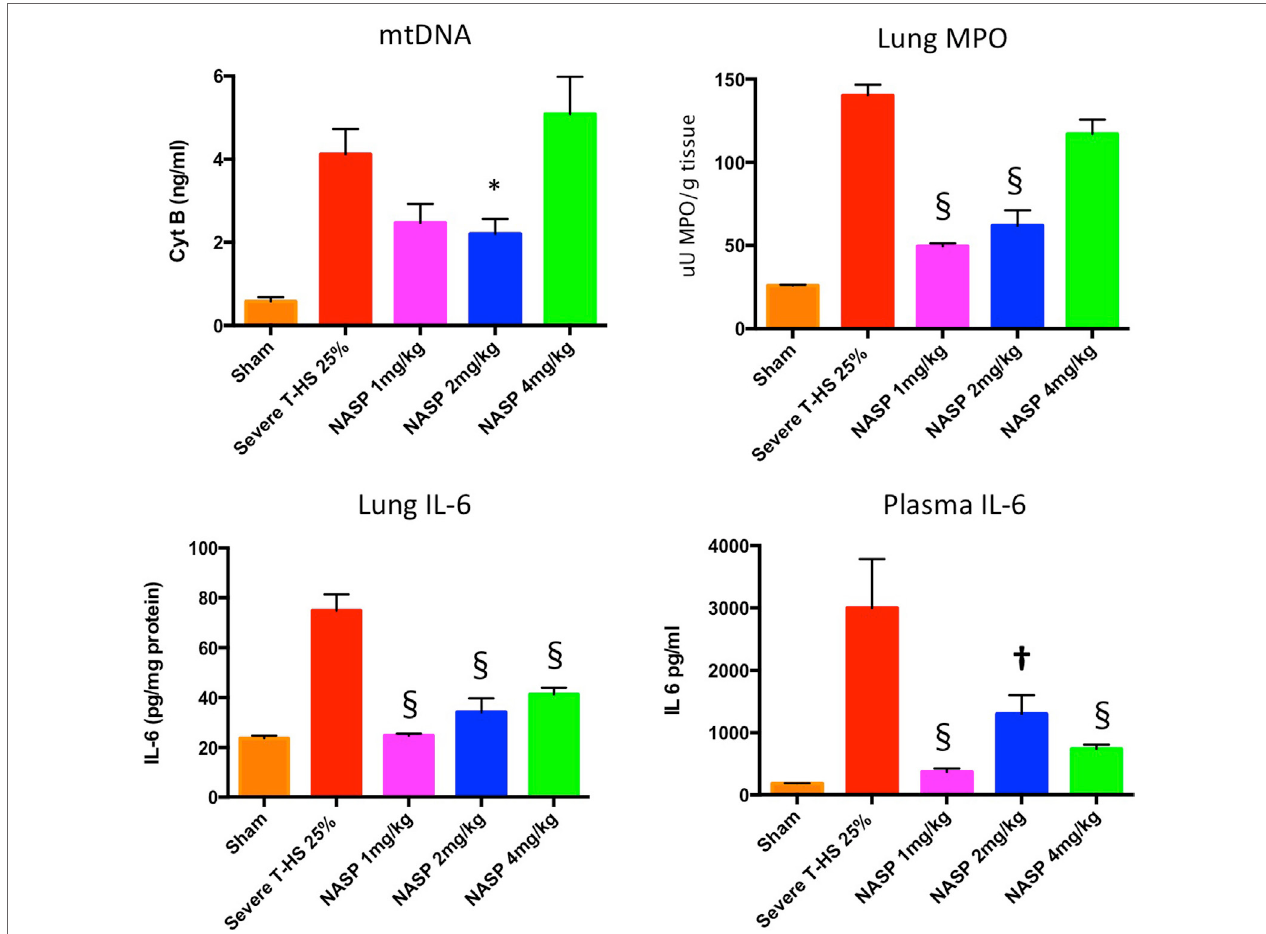
FigUre 4 | A 6-h plasma mitochondrial DNA (mtDNA), lung inflammation scores and systemic IL-6. Cell-free mtDNA was measured with real time polymerase chain reaction using cytochrome B as the target gene: Severe T-HS 25% resulted in an approximately eightfold increase in mtDNA compared to sham, 0.57 ( ± 0.1) to 4.1 ( ± 0.6) ng/ml, p < 0.0001, t -test. The addition of nucleic acid scavenging polymer (NASP) (hexadimethrine bromide) 1 mg/kg post injury resulted in a non-significant trend toward reduced mtDNA, mean 2.46 ( ± 0.46) ng/ml, p = 0.06. NASP 2 mg/kg reduced circulating plasma mtDNA by half to 2.2 ( ± 0.36) ng/ml, *